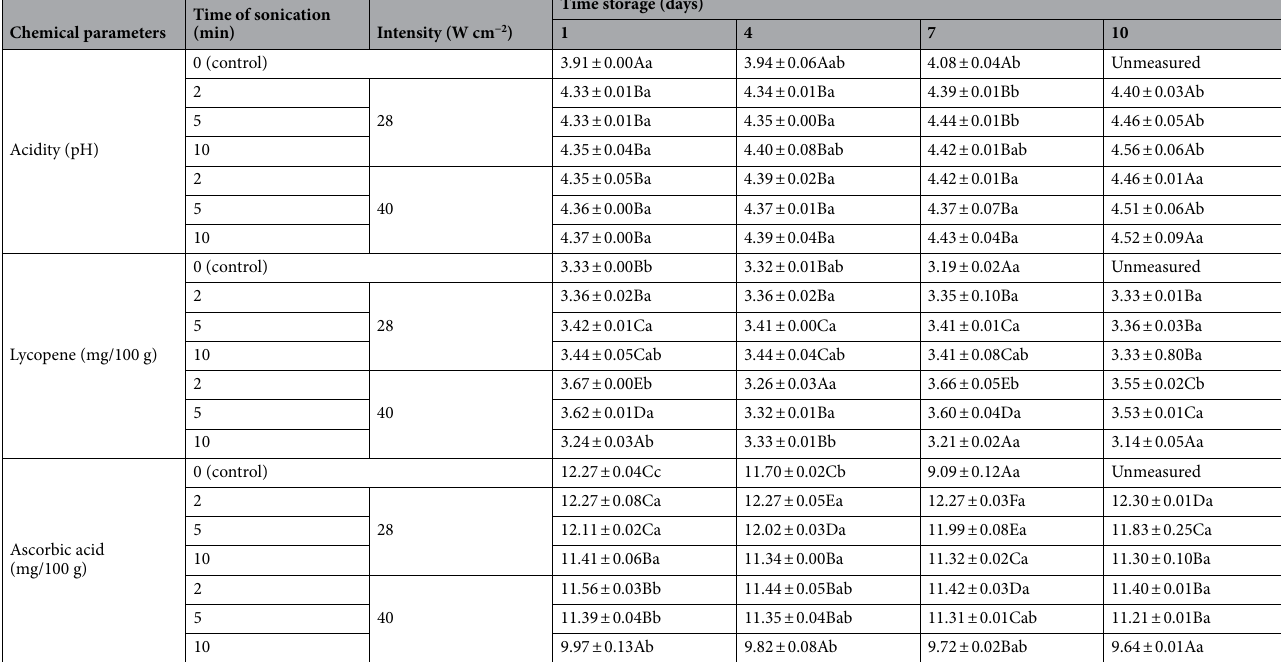
Table 1. Effect of sonication parameters on the chemical properties of tomato juice stored for 10 days. The results are expressed as a mean ± standard error. Average values in the column marked with the same capital letter are not statistically significantly different (p < 0.05). Average values in the raw small marked with the same small letter are not statistically significantly different (p < 0.05).